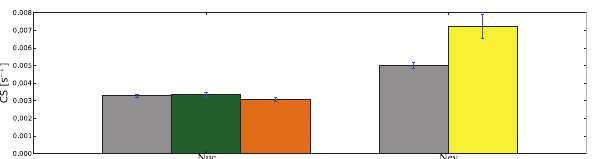
Fig. 7. Condensational sink average values with standard deviations for event days (Nuc) and non-event days (Nev) at the puy de Dˆome station when LWC ¡ 0.02 gm − 3 . Grey bars represents the general case, when the nucleation is observed at the puy de Dˆome station (Nuc) or not (Nev). The green and the orange bars are respectively for a nucleation events that occur only at the puy de Dˆome station ( N =70) and an event that occur at both measurement sites ( N =87). The yellow bar is for events that only occur at the Opme station ( N =4).